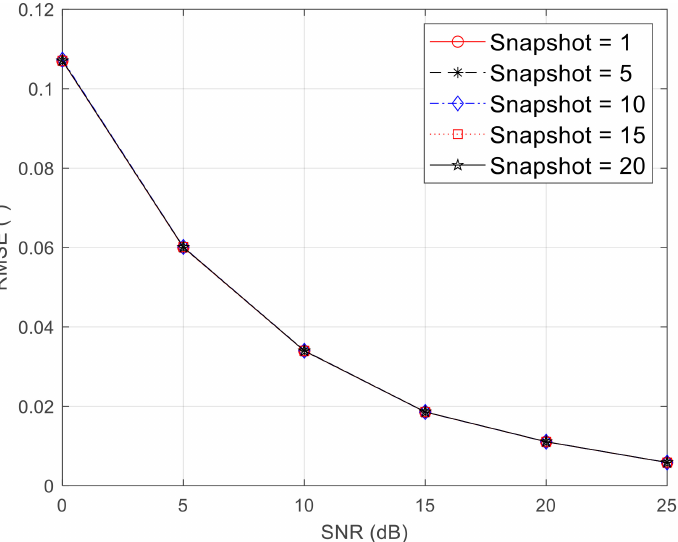
Figure 4. Comparison of root mean square error (RMSE) of direction-of-arrival (DOA) according to the number of the snapshot for the target detected in the R-D map.